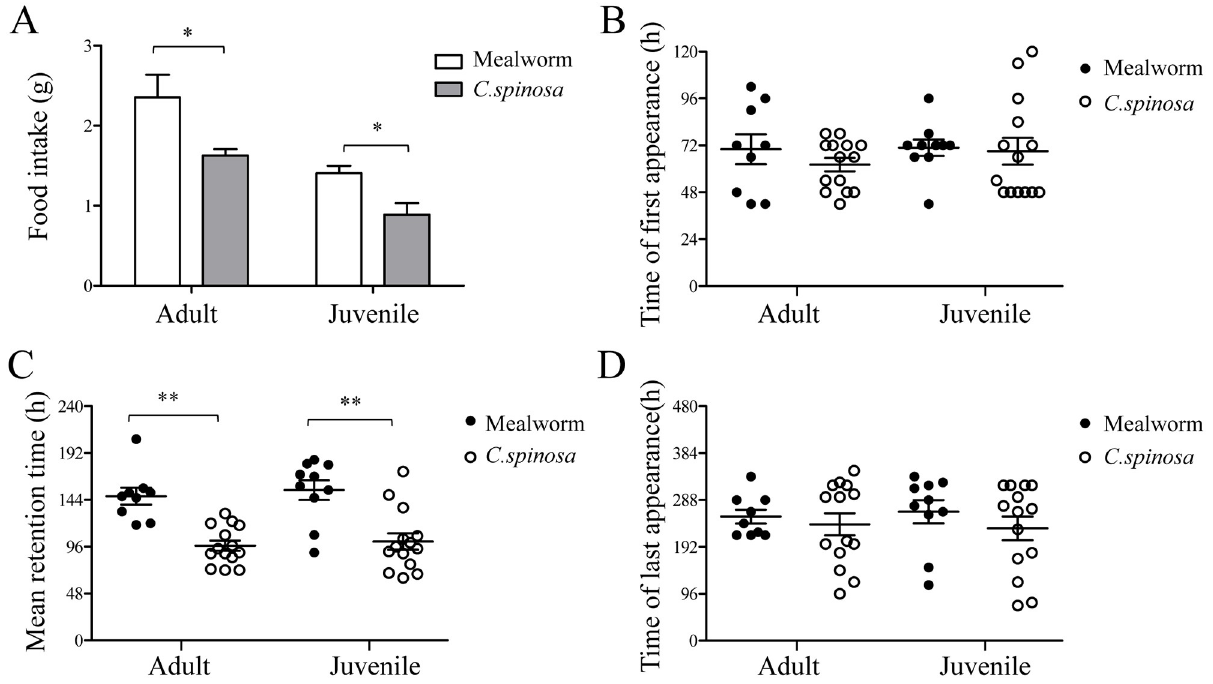
Fig 2. Effects of age and food type on food intake and digesta retention time in adult and juvenile lizards. (A) The intake of mealworms and C . spinosa in adult and juvenile lizards. (B-D) The TFAs, MRTs and TLAs of mealworms and C . spinosa in adult and juvenile lizards. The data were analyzed by a two-tailed paired t test. � P < 0.05; �� P < 0.01.